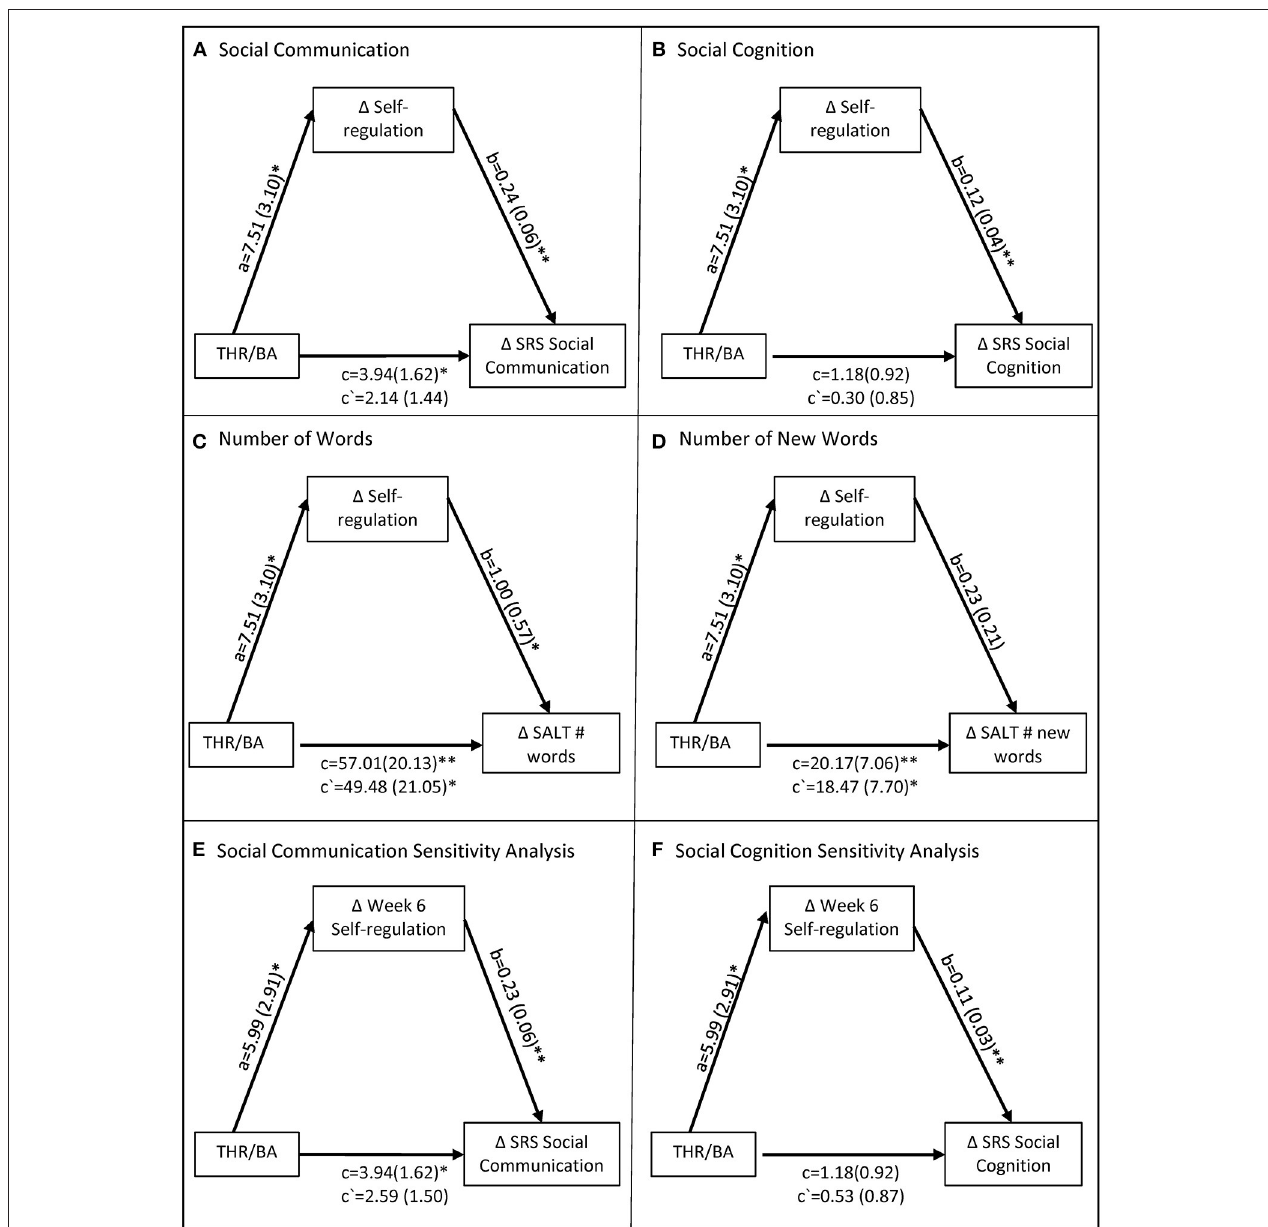
FIGURE 1 | Mediation models of THR’s effect on social and language outcomes through self-regulation. Models depict the total effect c, direct effect c’, intervention mediator effect a, and the mediator-outcome effect b. Mediation inferences were determined by the confidence interval of the indirect effect ab which is provided in text, not pictured here. Models (A–D) depict the primary analyses and models (E,F) depict the sensitivity analyses. BA , Barn Activity Group; THR , Therapeutic Horseback Riding Group; SRS , Social Responsiveness Scale; SALT , Systematic Analysis of Language Transcripts. *indicates p < 0.05. **indicates p <